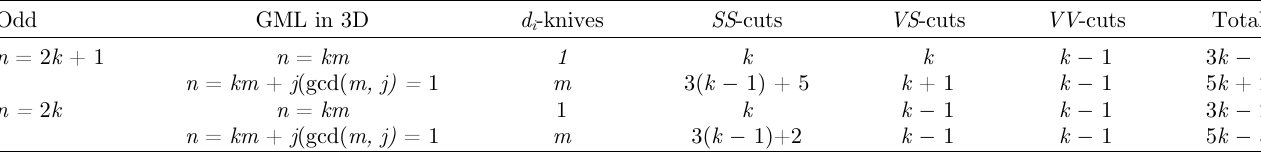
Table 4. Comparative table for GML and polygon